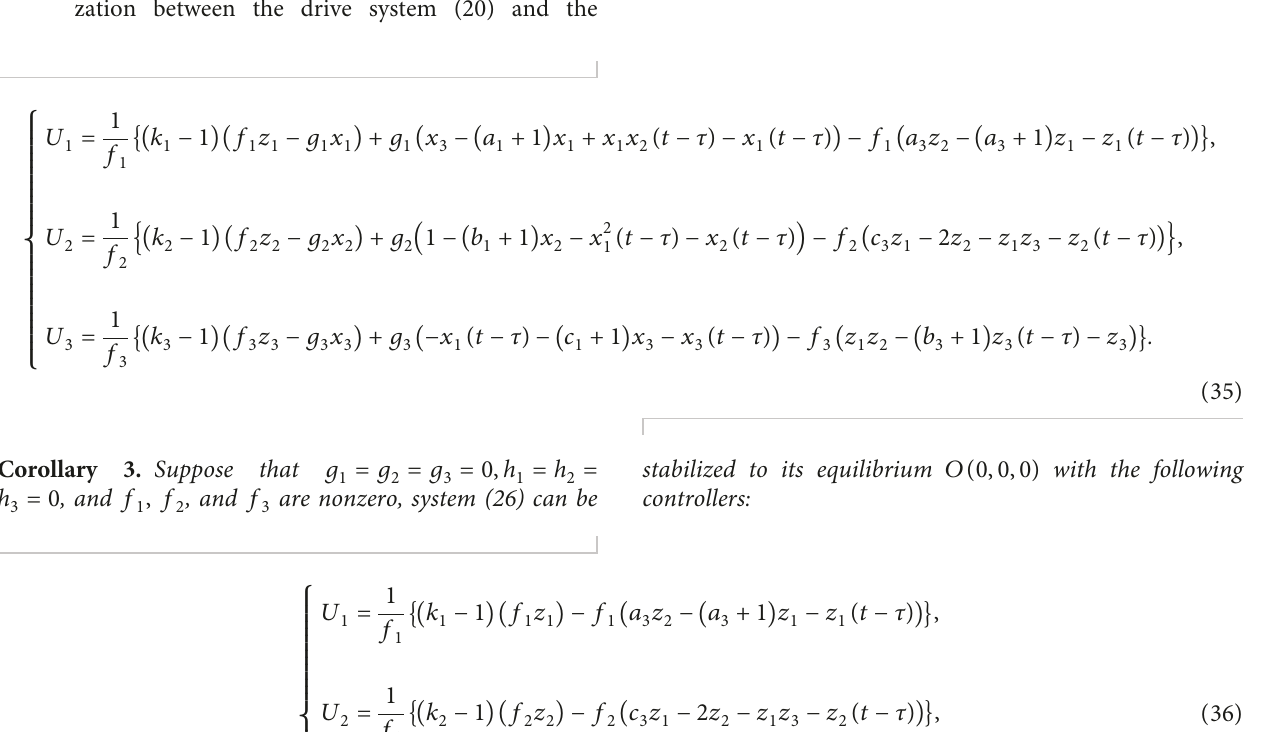
between drive systems (20) and (23) and response system 1